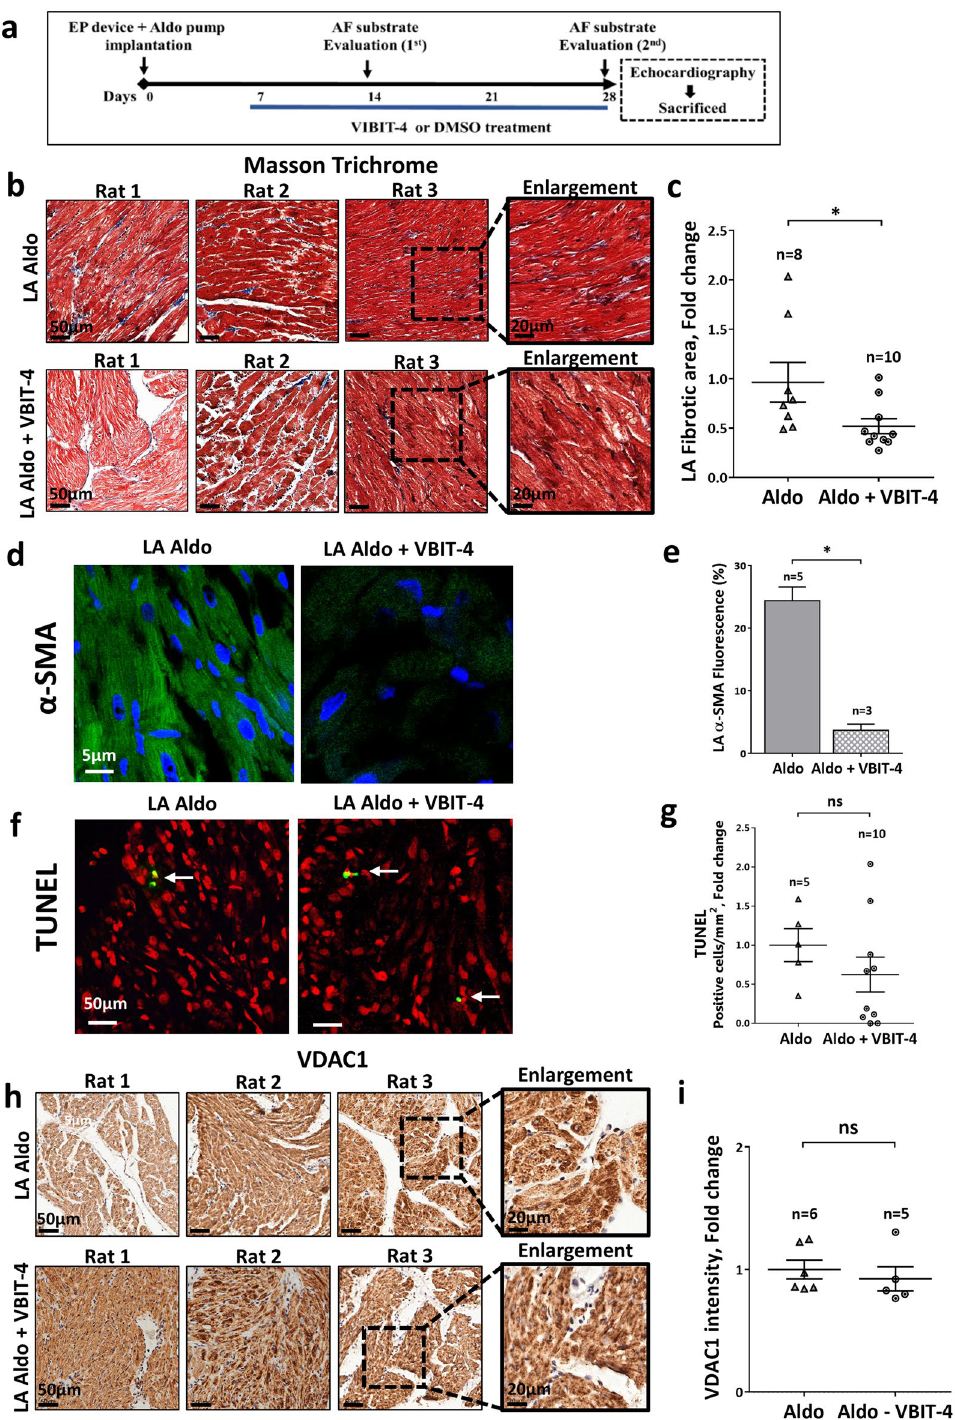
Figure 7. Attenuating effect of VBIT-4 on atrial fibrosis induced by hyperaldosteronism. ( a ) Schematic outline of the interventional study of VBIT-4 (see “Methods” section for technical details of the experimental protocol). ( b , c ) MT staining and quantitative analysis of myocardial fibrosis in the LA of Aldo and Aldo + VBIT-4-treated rats. ( b ) Representative photomicrographs for each condition. Scale bars, 50 µm and enlargement 20 µm. ( c ) Summarizing scatter plot of quantitative image processing analysis. Note a decrease in LA fibrotic area following VBIT-4 treatment. ( d , e ) IF staining of α-SMA expression in the atrial tissues of the sham and Aldo rats . ( d ) Representative photomicrographs for each condition. Scale bars, 5 µm. ( e ): Quantitative analysis of image expressing α-SMA. ( f , g ) TUNEL staining analysis (as in Fig. 4) in LA tissues of Aldo and Aldo + VBIT-4 treated rats. ( f ) Representative photomicrographs for each condition. Scale bars, 50 µm. ( g ) Summarizing scatter plot of quantitative image processing analysis. ( h , i ) VDAC1 IHC staining intensity in the LA. ( h ) Representative photomicrographs for each condition. Scale bars, 50 µm and enlargement 20 µm. ( i ) Summarizing scatter plot of quantitative image processing analysis. The number of rats in each group is indicated (n =